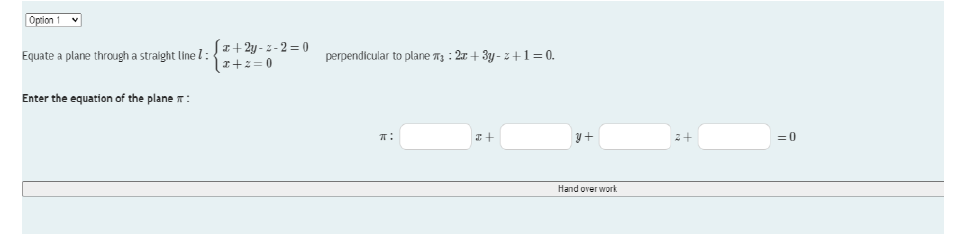
Fig. 1. The problem of finding the equation of the